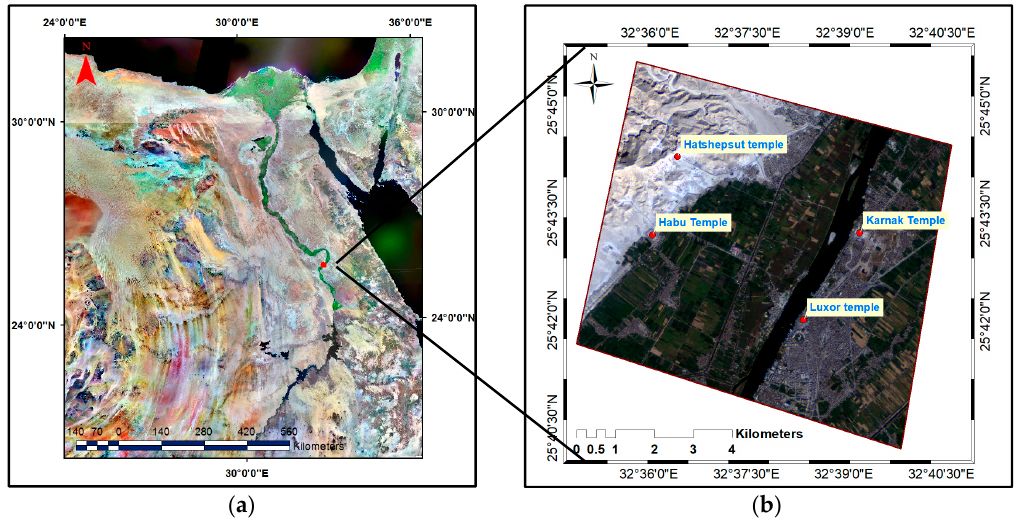
Figure 1. Map of Egypt by Landsat 7 ( a ) and study area by Sentinel-2 11/2016 (Composite RGB 4, 3, 2) ( b ).